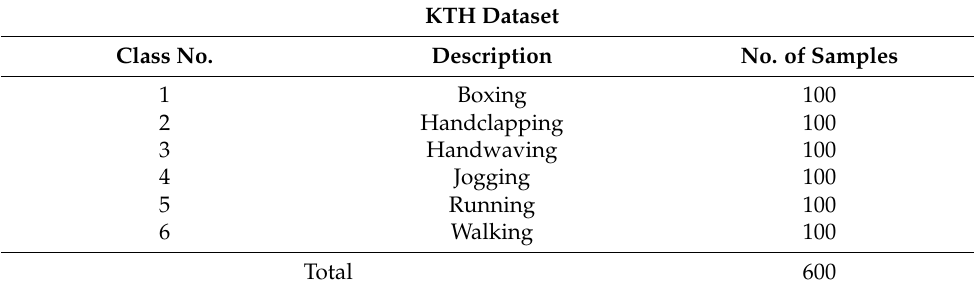
Table 1. Details of KTH